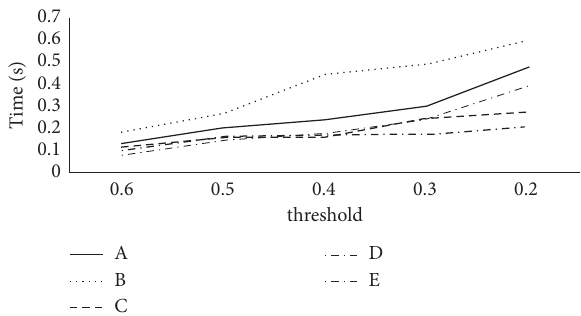
Figure 7: The running time of the algorithm under different